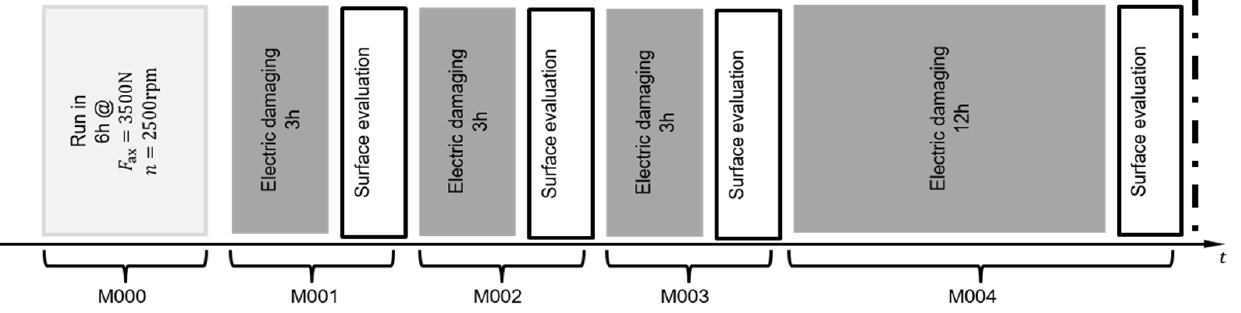
Figure 4. Test setup. For measurements of the runway surfaces, the white light interferometer Smart WLI from GBS is used. It enables a three-dimensional gauging of the surfaces to detect micro geometries and surface roughness. Using the Smart WLI, each bearing ring is measured at four marked positions on each bearing ring to ensure the comparability of the measure- ments after each damaging period. These areas are designated as “N”, “E”, S” and “W”. The area “N” is marked by two engraved dots, the other areas by one dot (c.f. Figure 5). Each scanned area has the size of about 2 mm × 0.7 mm.